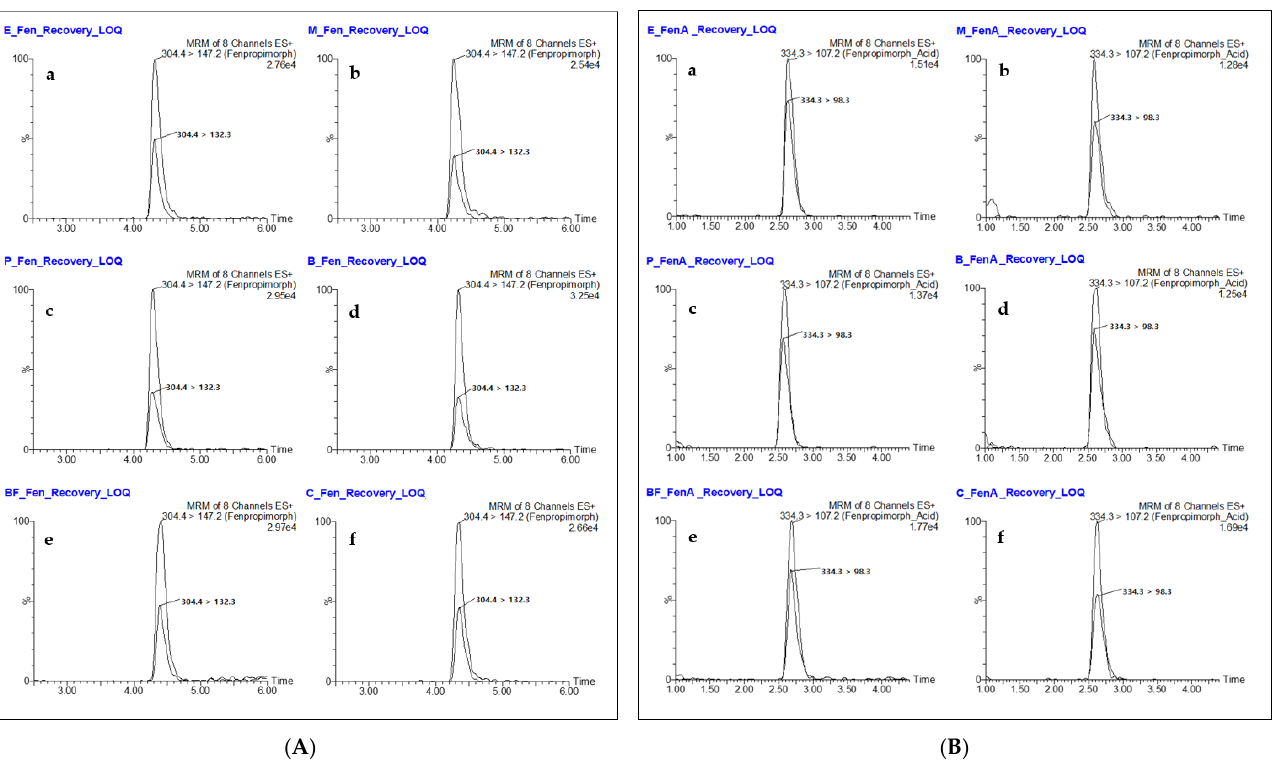
Figure 2. Typical LC-MS/MS chromatograms of two transitions of fenpropimorph ( A ) and fenpropimorph acid ( B ) fortified at the LOQ level in the egg ( a ), milk ( b ), pork bacon ( c ), beef steak ( d ), beef fat ( e ), and chicken leg meat ( f ) samples. Table 5. Relative differences of the ion ratios of fenpropimorph and fenpropimorph acid in the livestock matrices. Chemical Level